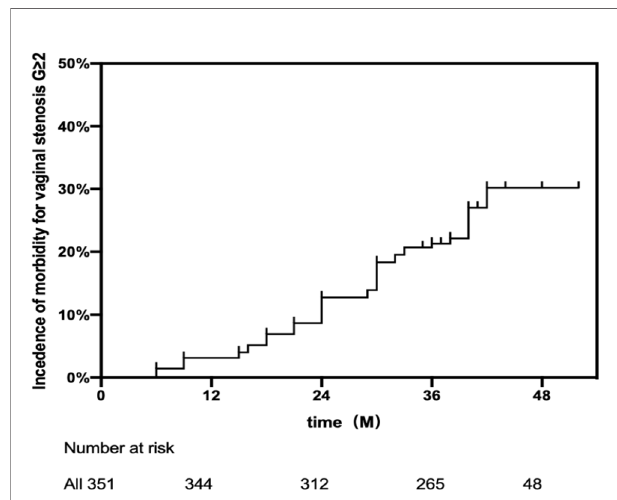
FIGURE 1 | Cumulative incidence for vaginal stenosis G ≥